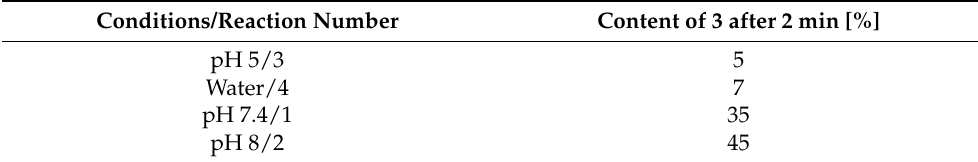
Figure 3. pH-dependent uridine formation in the reaction of 10 mM Se2U with 10 mM H 2 O 2 at room temperature and in phosphate buffers pH 8.0, 7.4, and 5.0, as well as in deionized water (pH 6.5), observed by 1 H NMR monitoring 2 min after the start of the reaction. The arrows indicate the resonance signals for 2 , 3 , and the reference thymine (T) used at the same concentration (5 mM). Table 3. The content of uridine 3 in the reaction mixture (in %).